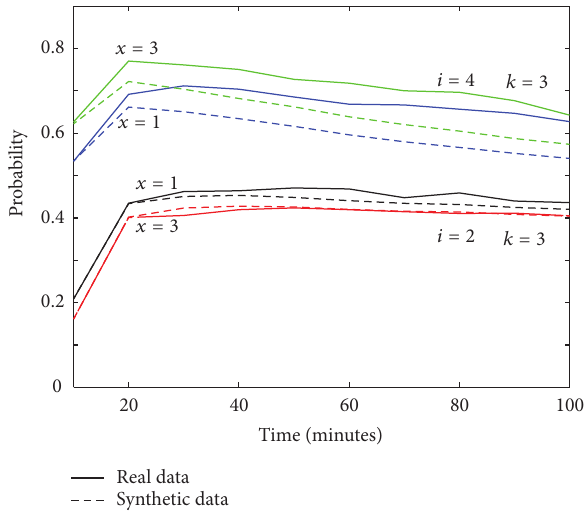
F 2: Comparison of availability functions for real and simu- lated data.